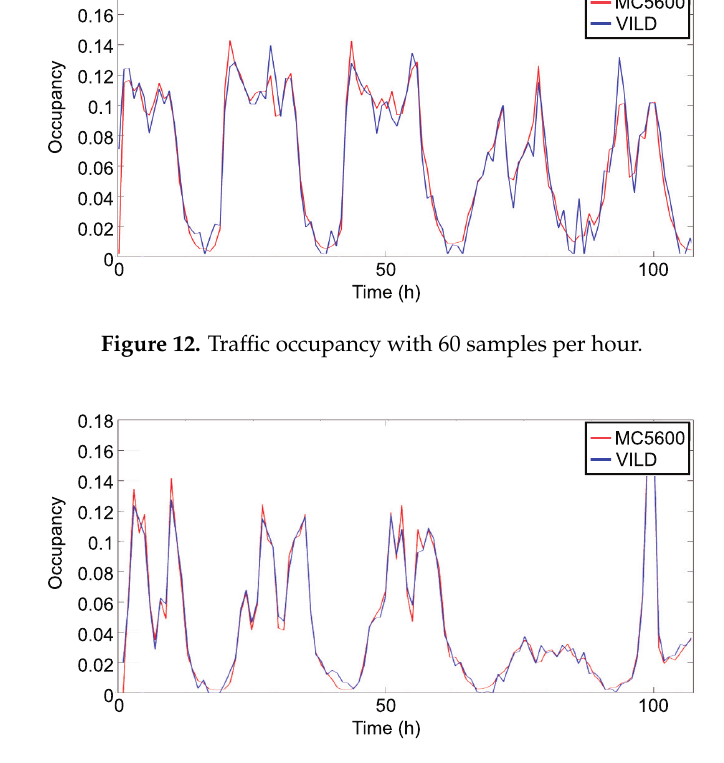
Figure 13. Traffic occupancy with 60 samples per hour (opposite